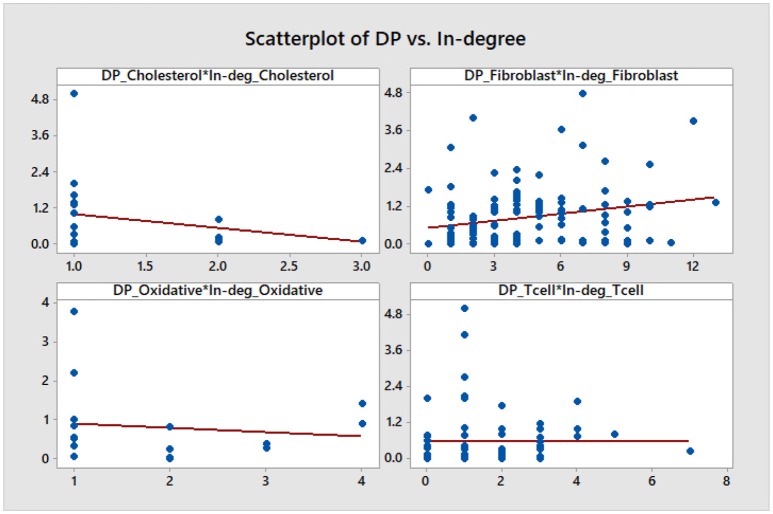
Simple scatter plots for DP vs. in-degree. R2∈[0%, 7.3%].